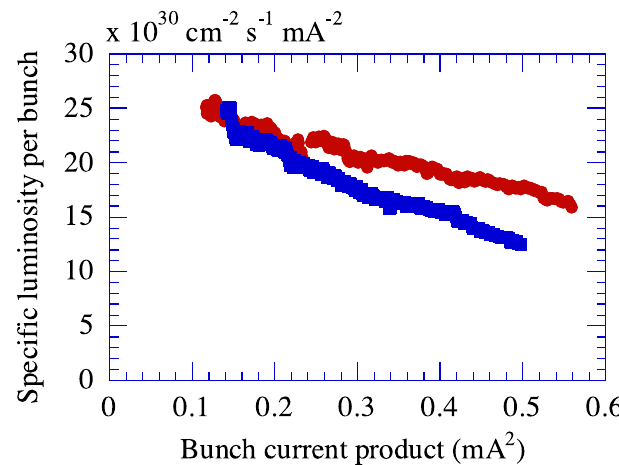
FIG. 12. (Color) Specific luminosity per bunch as a function of the product of bunch currents. The red dots and blue dots represent the specific luminosity at (cid:8) þ x 0 þ (cid:8) (cid:3) x 0 ¼ 18 þ þ (cid:8) (cid:3) ¼ 15 þ 18 nmrad , respectively, mea- 24 nmrad and (cid:8) þ x 0 x 0 sured with a fixed betatron function at the IP.